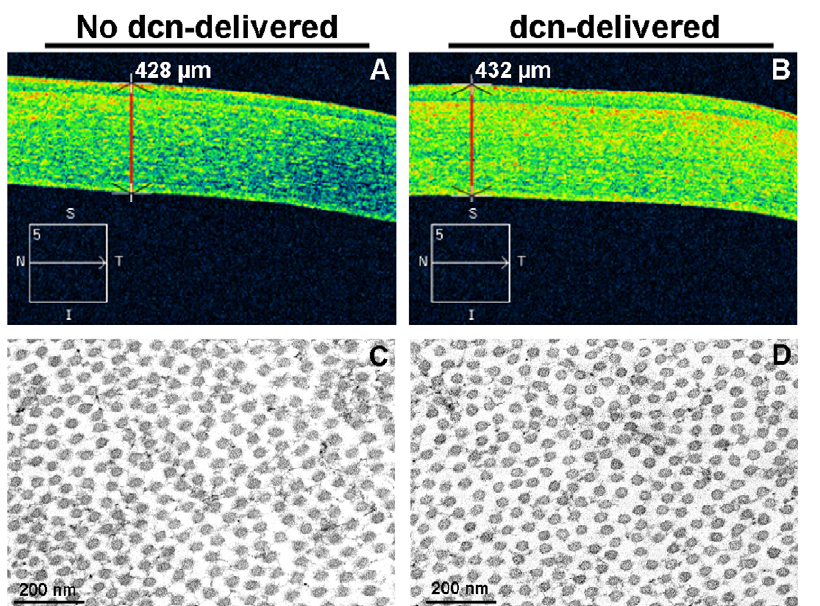
Figure 8. Representative optical coherence tomography (A and B) and transmission electron microscopy (C and D) images of rabbits receiving AAV5-gfp or AAV5-dcn. Optical coherence tomography was performed in live rabbits on day 10 after the AAV5-gfp or AAV5- dcn application and transmission electron microscopy was performed in corneas collected 14 days after AAV5-gfp or AAV5-dcn application. The optical scans of no decorin-delivered (A) and decorin-delivered (B) cornea suggest that tissue-selective targeted delivery of decorin gene with AAV5 in the rabbit stroma does not induce changes in corneal structure, thickness or shape. The TEM did not detect significant differences in collagen fibril diameter and arrangement in the naive (C) and decorin-delivered rabbit corneas (D) indicating that localized therapeutic levels of decorin delivery in the cornea does not appear compromise corneal health. dcn=decorin.